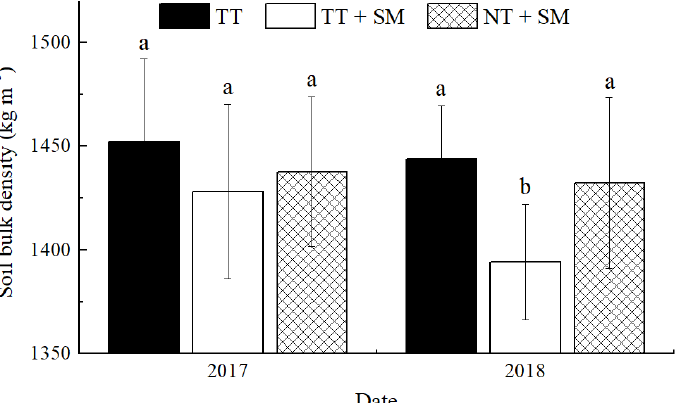
Figure 3. Mean soil bulk density to the depth of 30 cm for traditional tillage without straw return (TT), traditional tillage with straw mulching (TT + SM), and no-till cultivation combined with straw mulching (NT + SM) treatments. Data were measured before maize sowing. Mean values within the same year followed by a different letter are significantly different ( p = 0.05).